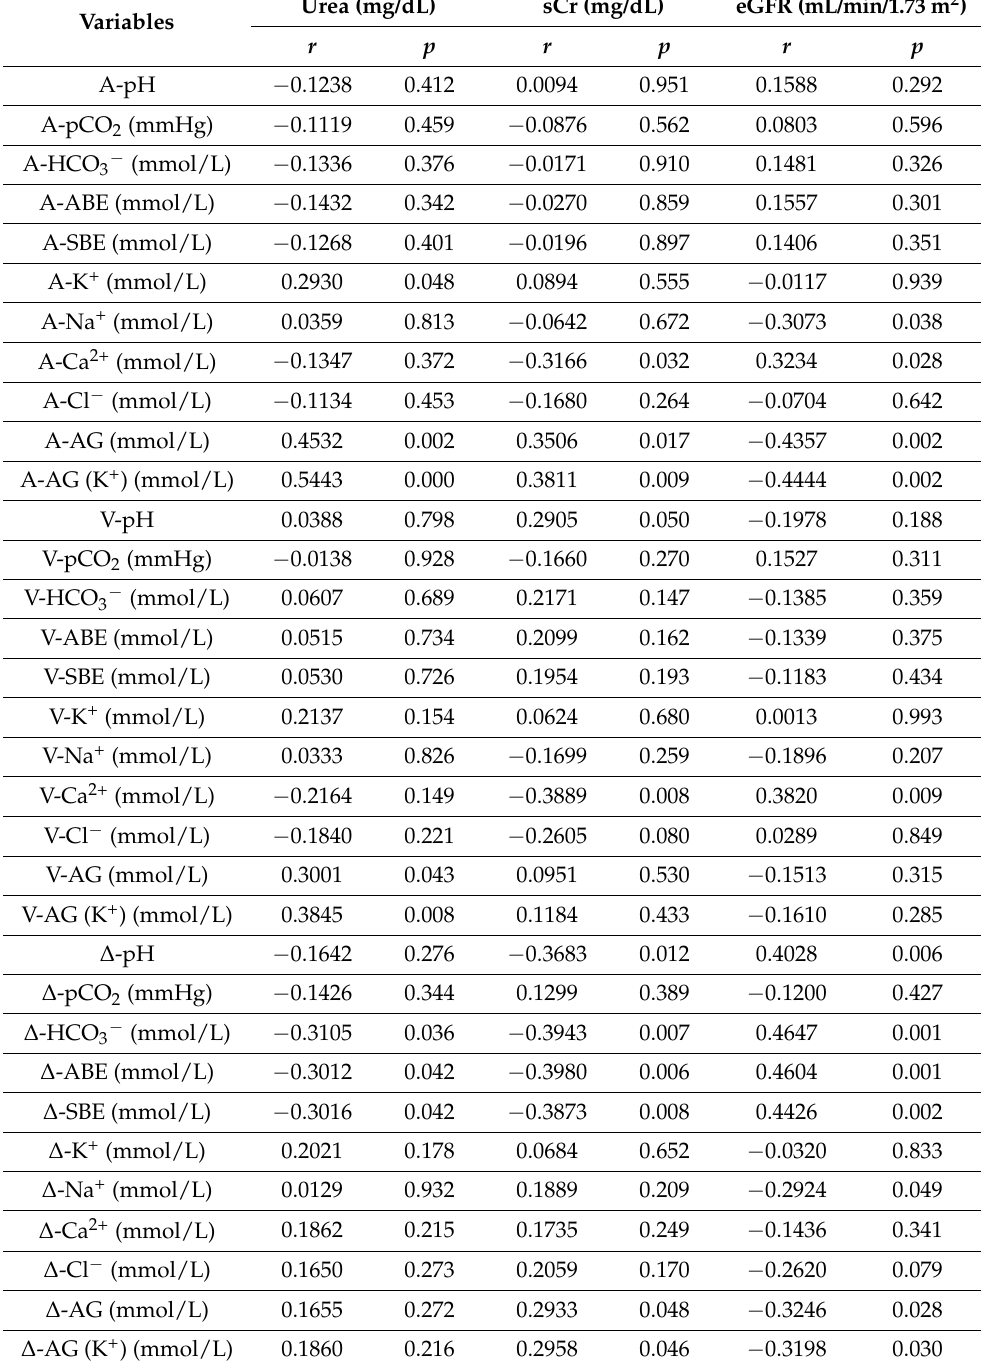
Table 3. Pearson’s correlation of urea, serum creatinine (sCr) and eGFR with parameters of acid- base